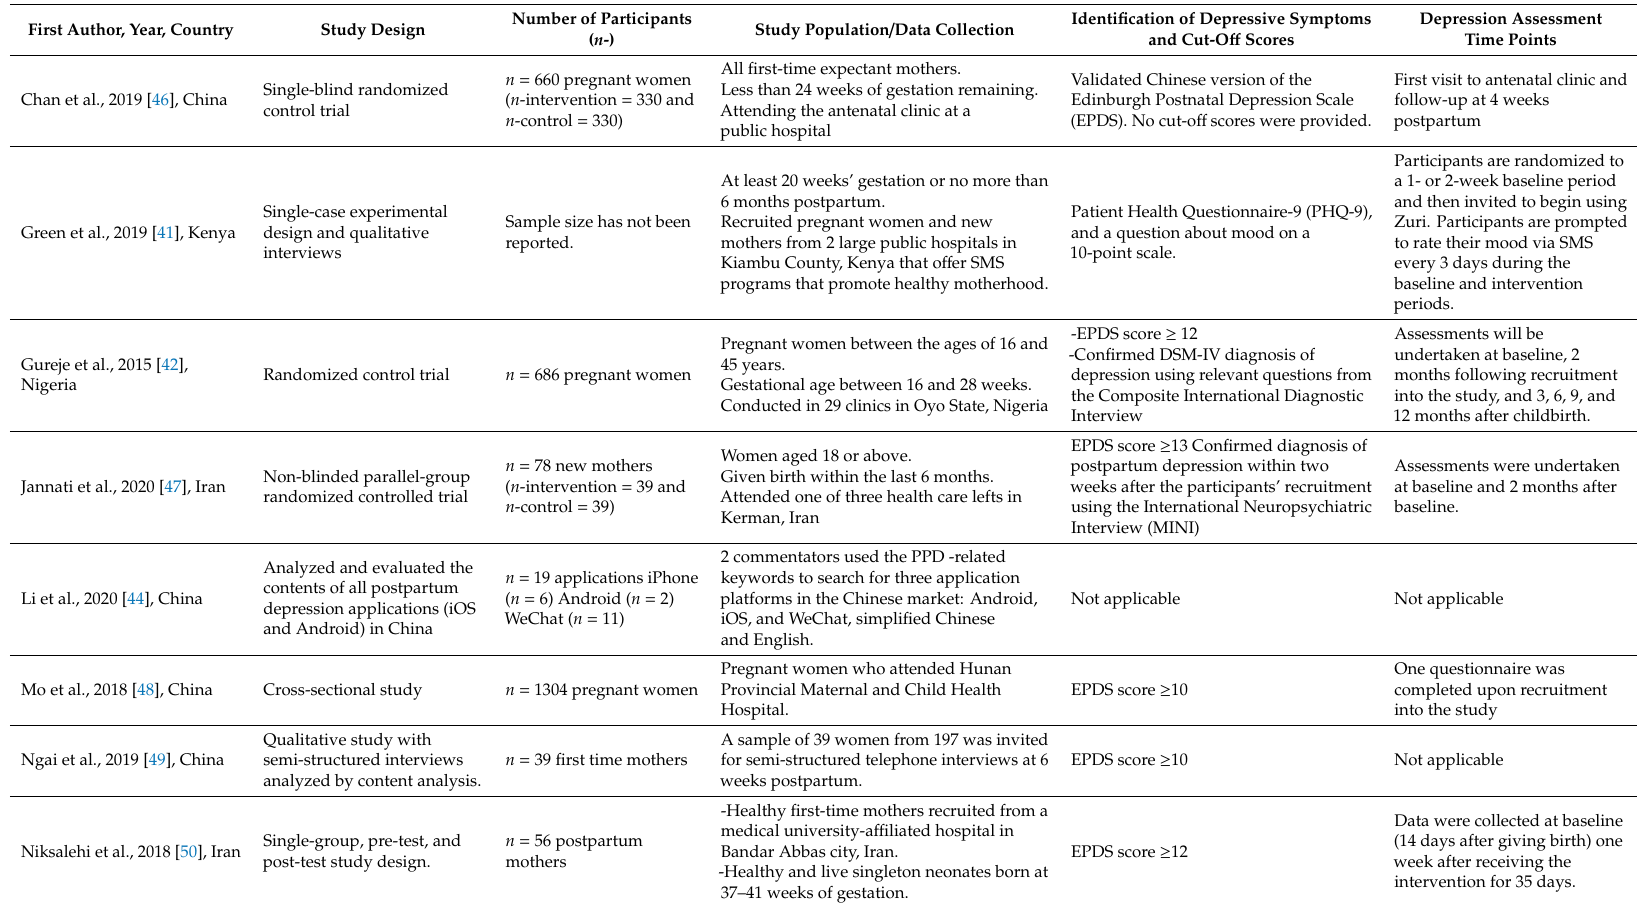
Table 2. Data extraction: study design, study population, and details of the